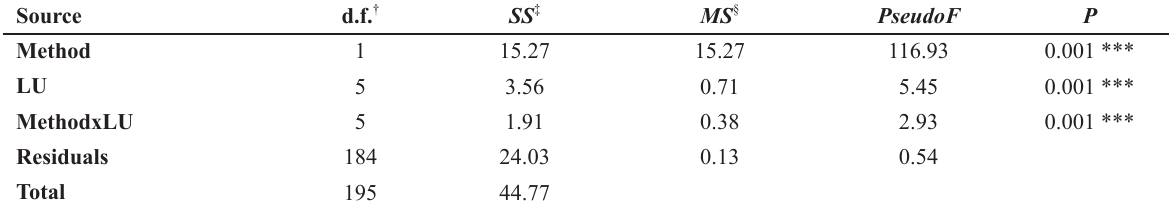
PERMANOVA on Jaccard dissimilarity matrix for AMF communities sampled by two methods in six different land